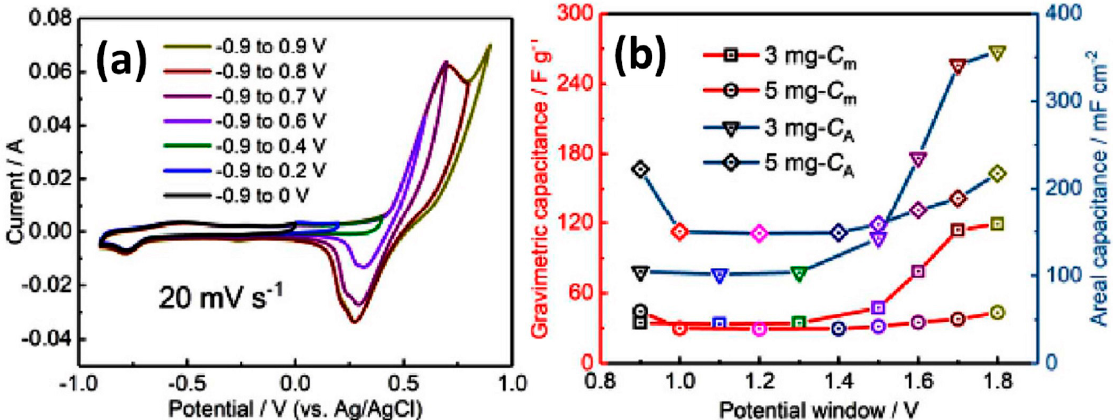
Figure 20. CV curves at different potential windows measured for CNT@G electrodes with 3 mg/cm 2 mass loading at 20 mV/s ( a ) and relationship between the potential window and gravimetric (or specific) capacitance (C m ) and areal capacitance (C a ) for CNT@G electrodes with mass loading of 3 mg/cm 2 and 5 mg/cm 2 ( b ) (Reproduced with permission of [46]. Copyright Elsevier,